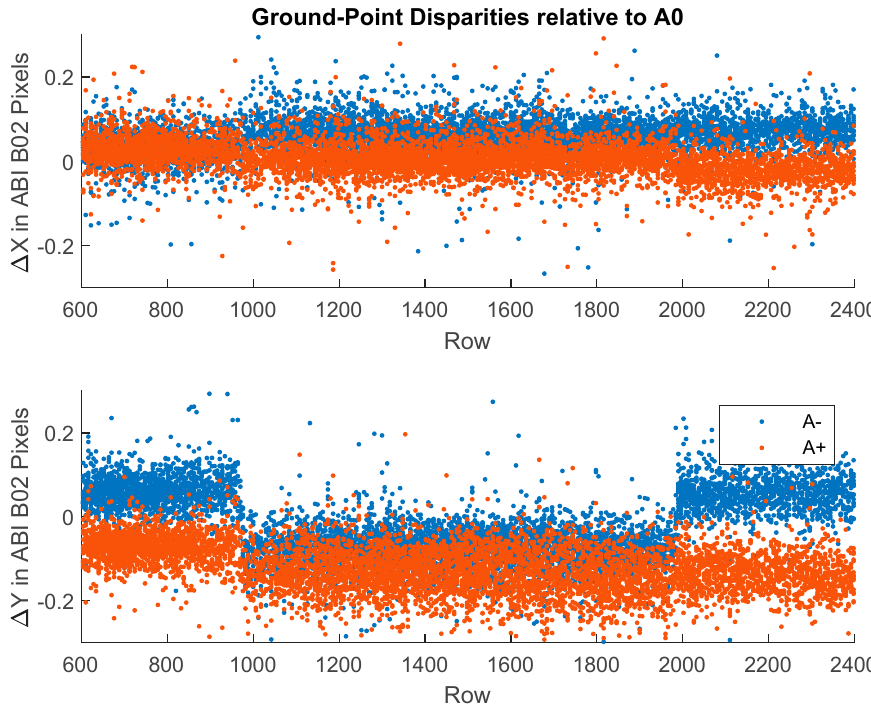
Figure 25. Observed FFR error as a function of CONUS scene row number shows a jump in swath-to-swath registration (SSR) at swath boundaries. The A0 scene is a B02 CONUS image from GOES-16 at 2020/207 17:16. The upper panel shows the FFR in the East-West direction and the lower panel shows the North-South direction.